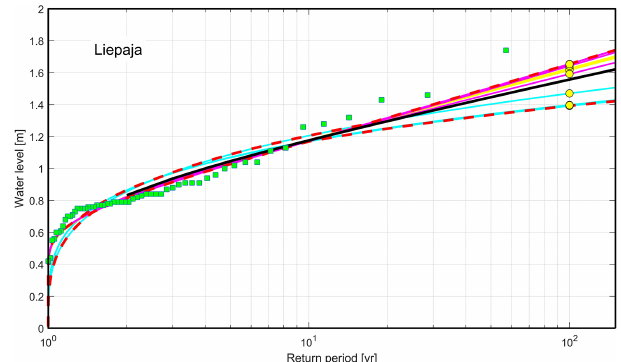
Figure 4. Return periods of extreme water levels in Liep ¯ aja eval- uated using two-parameter Weibull (cyan), Gumbel (yellow), and GEV (magenta) distributions. Green squares indicate block max- ima, and yellow circles show different values for a return period of 100 years. Bold dashed red lines show limits of minima and max- ima of the ensemble of projections. The bold black line indicates the mean of projections. There are six positive outliers at